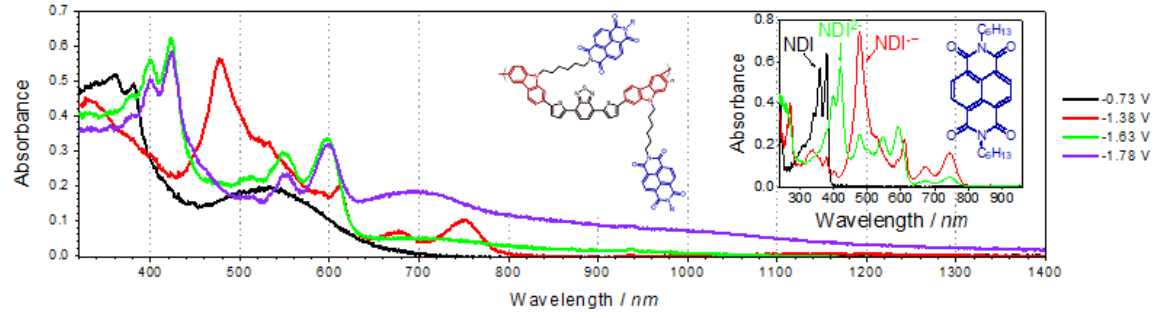
Figure 9. UV–Vis–NIR spectra recorded at different potentials. Reprinted with permission from [19]. Copyright 2019 American Chemical